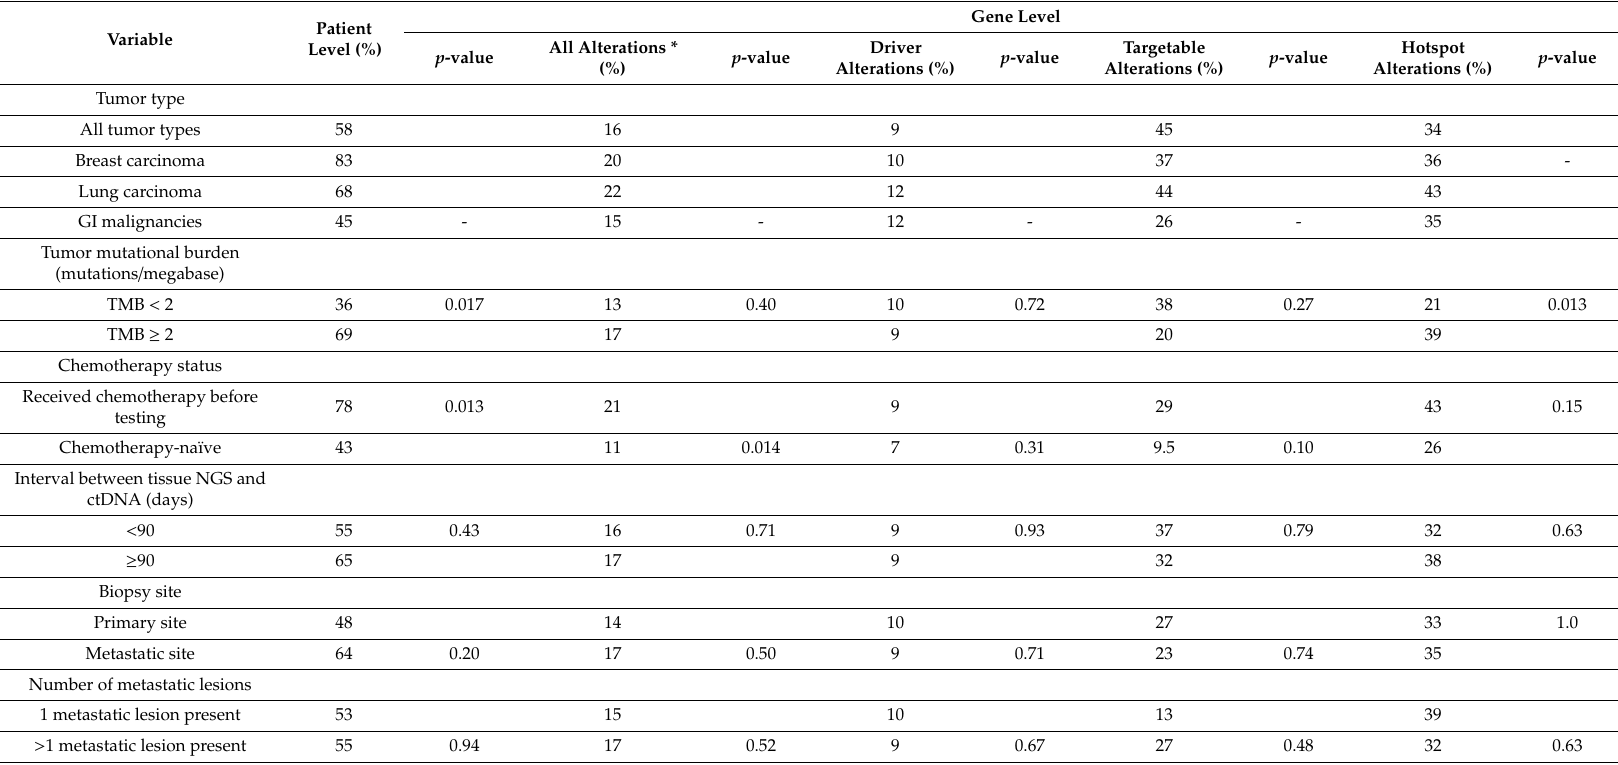
Table 2. Percent concordance (%) at patient and gene